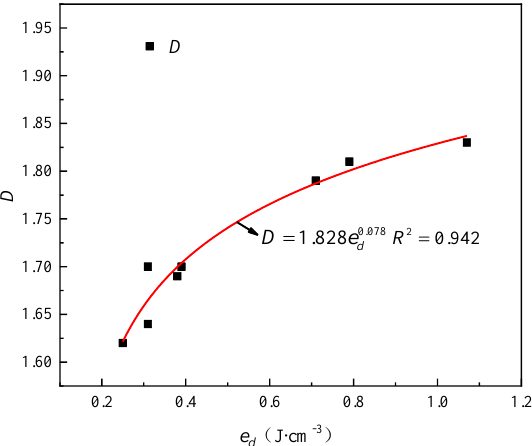
Figure 13. Fractal dimension D and energy consumption density e d . In general, with increasing energy dissipation density, the fractal dimension D pro- gressively increases. The fractal dimension D increases from 1.62 to 1.83 when the energy dissipation density e d is increased from 0.25 J · cm − 3 to 1.07 J · cm − 3 , a 12.96% increase.